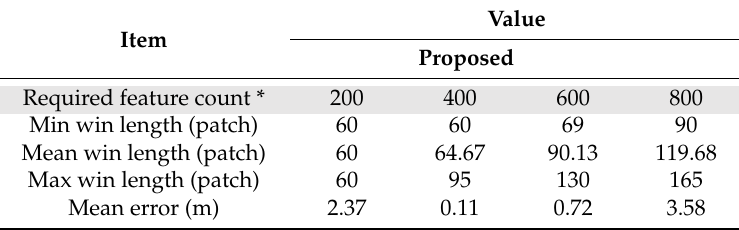
Table 6. Evaluation of the sensitivity of the framework to different numbers of required features. Value Item Proposed Required feature count *